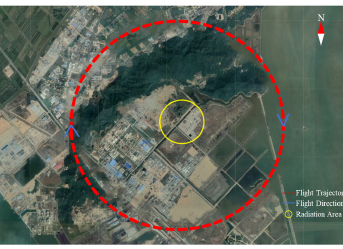
Figure 4. Optical image of the observing scene and airplane flight trajectory.